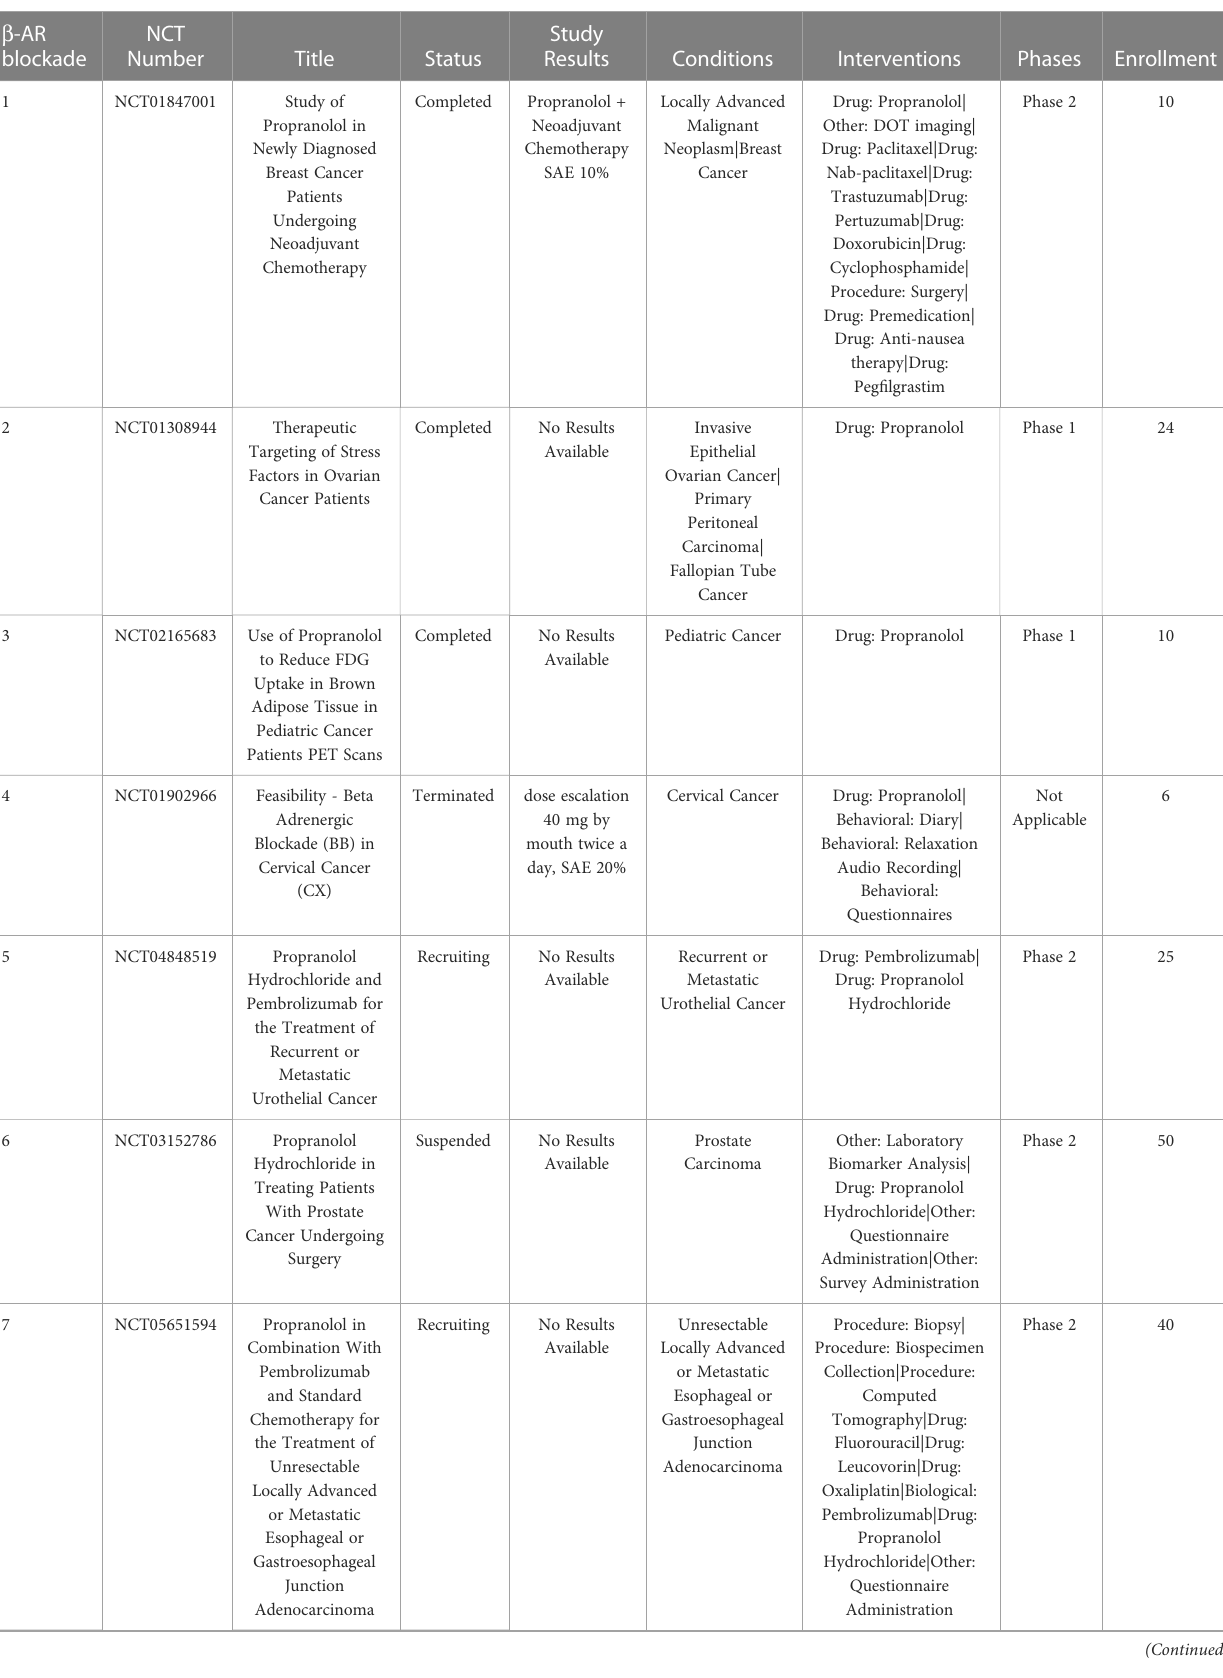
TABLE 8 US clinical trials using propranolol as cancer treatment. b -AR